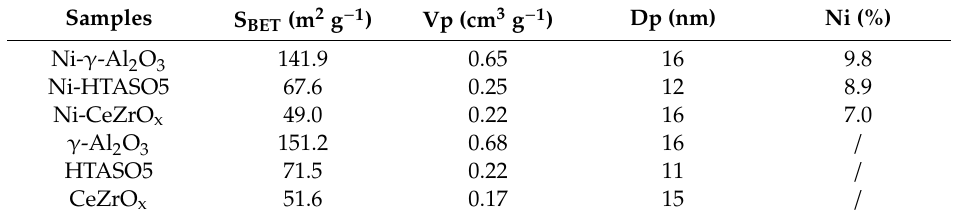
Figure 2. ( A ) N 2 adsorption–desorption isotherm curve and ( B ) pore-volume and size-distribution for di ff erent Ni-based catalysts after reduction. Table 1. Physical properties of di ff erent Ni-based catalysts and di ff erent supports, the surface area was determined by BET method, the pore size (Dp) and the pore volume (Vp) were both determined by BJH method. The loading content of Ni was detected by atomic absorption spectrum (AAS).